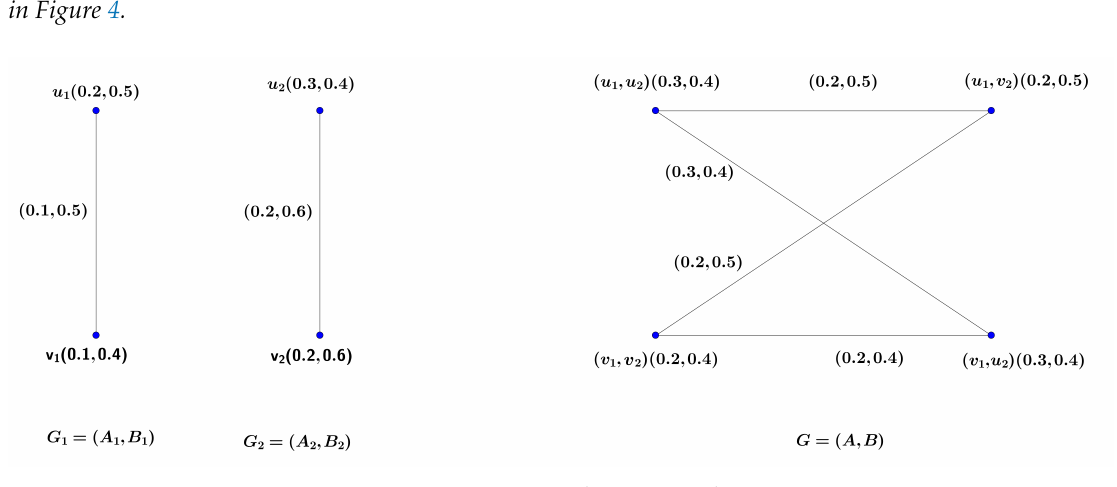
Figure 4. Vague graphs G 1 , G 2 and G